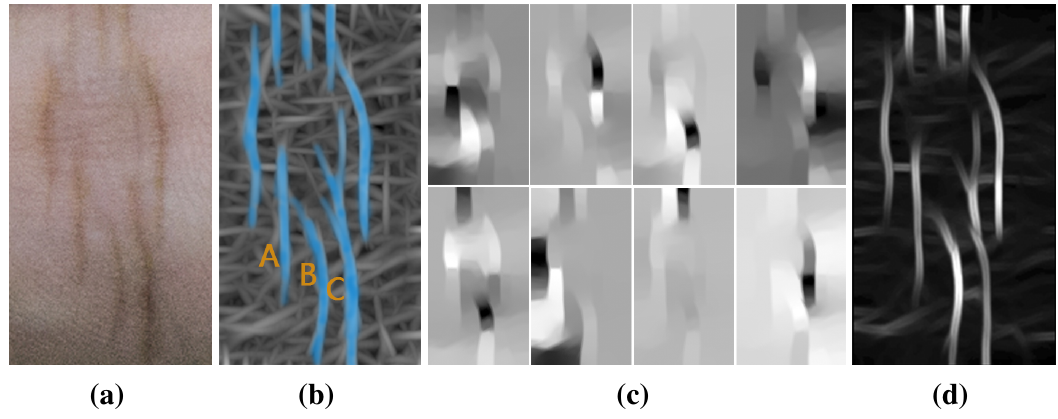
Figure 5. ( a ) The IKP image; ( b ) its magnitude map of CompCode can be divided into several regions (A, B, C, etc .) by the main structures of the IKP; ( c ) graphical illustration of eight non-zero eigenvalues; ( d ) the result of our global feature extraction